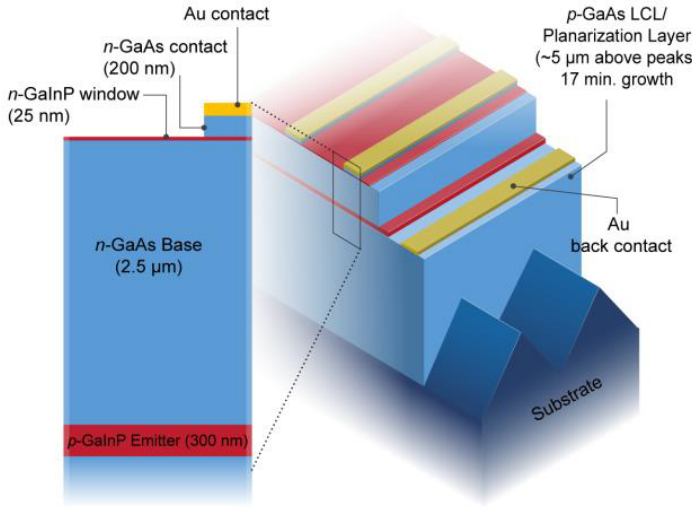
Figure 1. Structure of an upright rear heterojunction GaAs solar cell on a planarized spalled GaAs wafer. The facets and cell structure are drawn to scale. Devices on epi-ready GaAs use the same solar cell structure with a ~5 μm thick GaAs LCL grown prior to the cell stack.